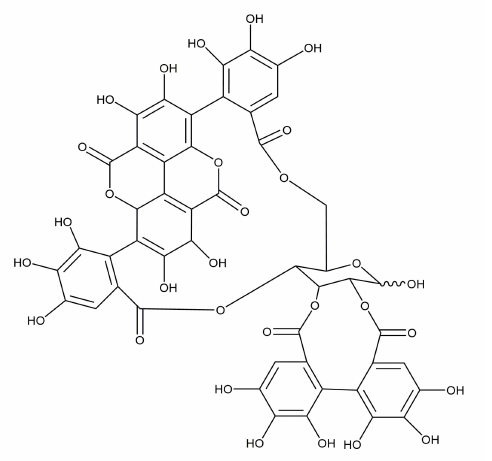
Figure 1. Chemical structure of punicalagins